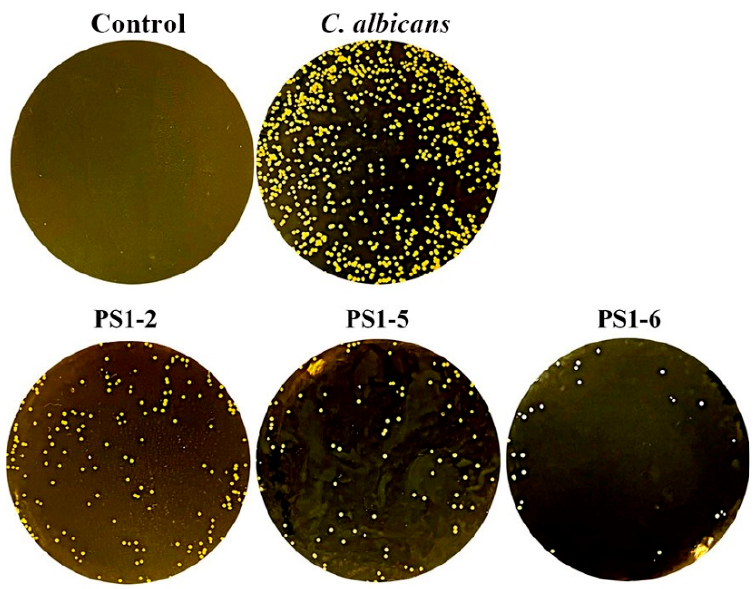
Figure 4. Protease protection effects of PS1-2, PS1-5, and PS1-6 peptide. After treatment of 1 µg/mL trypsin to peptide solutions of MFCs at 37 °C for 40 min, C. albicans CCARM 14007 was treated to the mixtures.